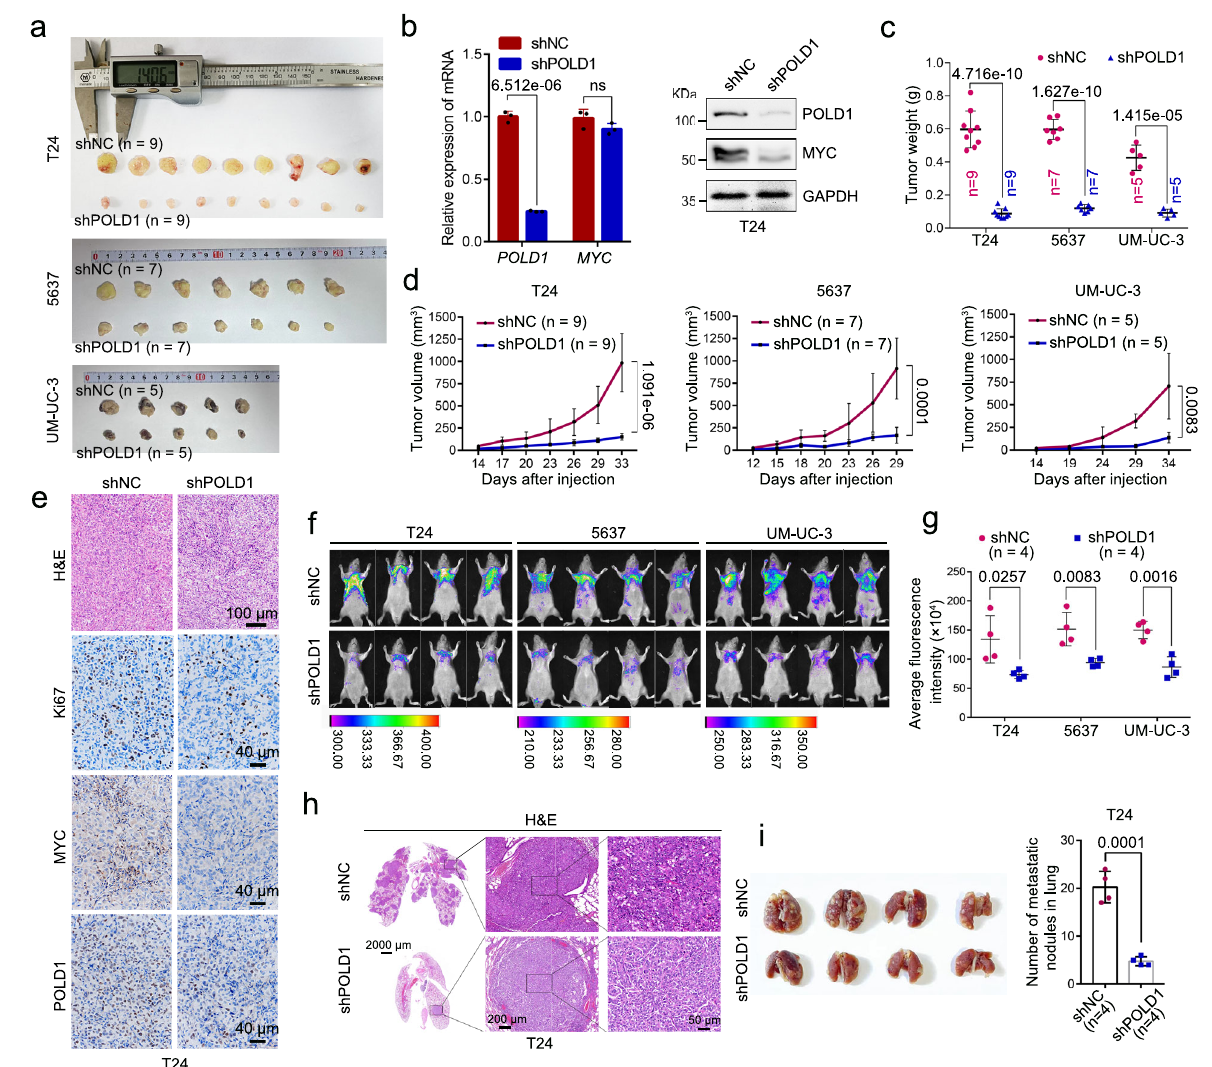
Fig.3|POLD1promotesBLCAproliferationandmetastasisinvivo.a Grossview ofasubcutaneoustumorderivedfromaxenograftmodel( shNC vs. shPODL1 )using